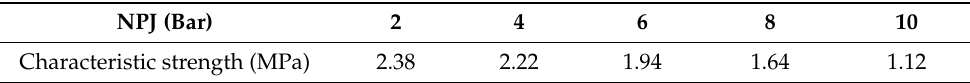
Table 12. The relationship between the characteristic strength and NPJ.